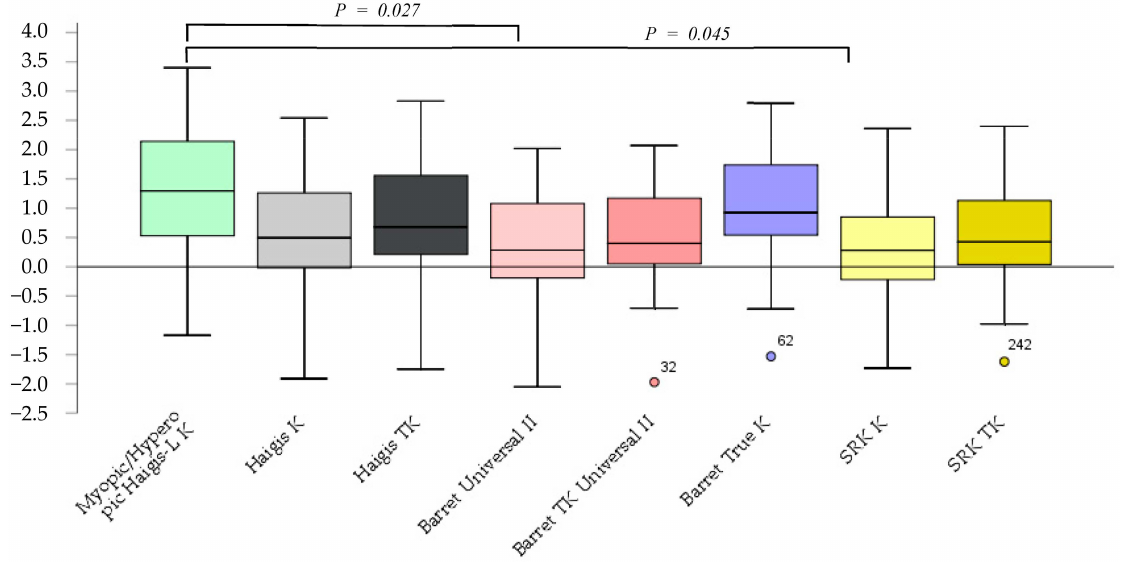
Figure 1. The prediction error after cataract